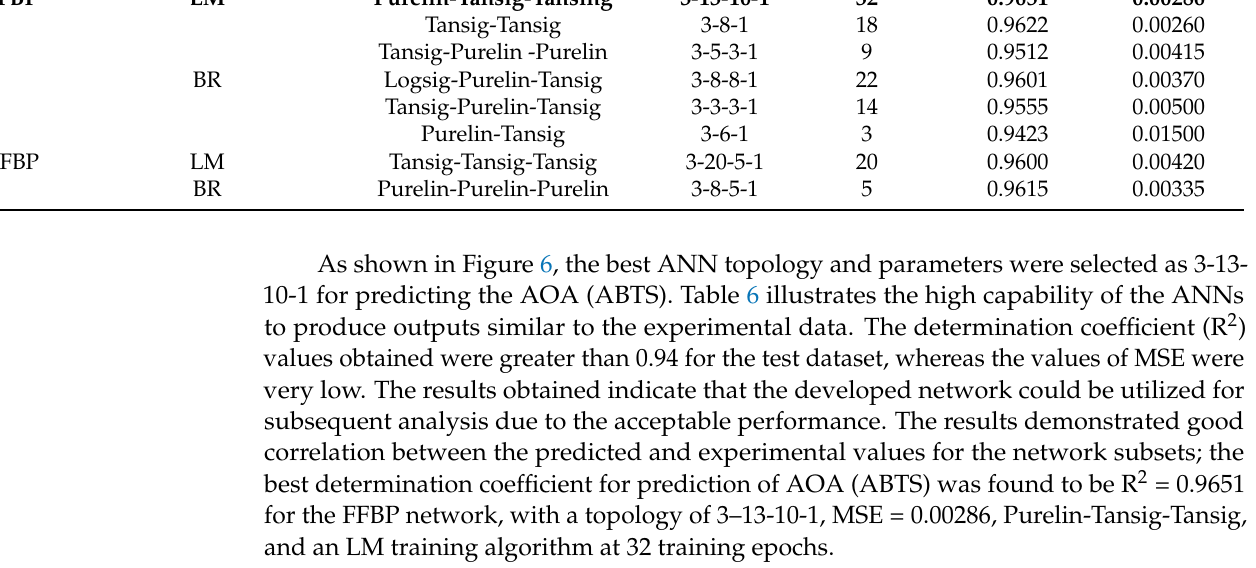
Table 6. Best topologies included in training algorithms, various layers and neurons for estimation of AOA (ABTS). Network